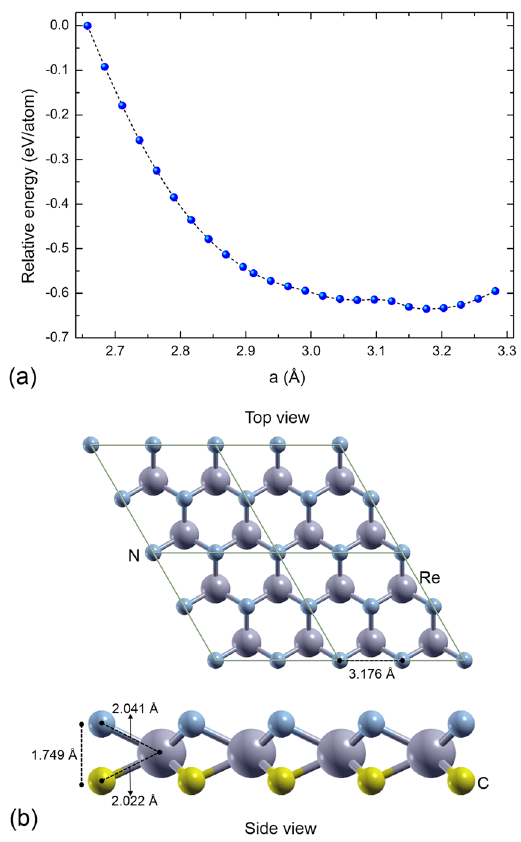
Figure 2. ( a ) Total energy as function of lattice parameter for a monolayer of ReCN. ( b ) Top and side view of the ReCN monolayer.